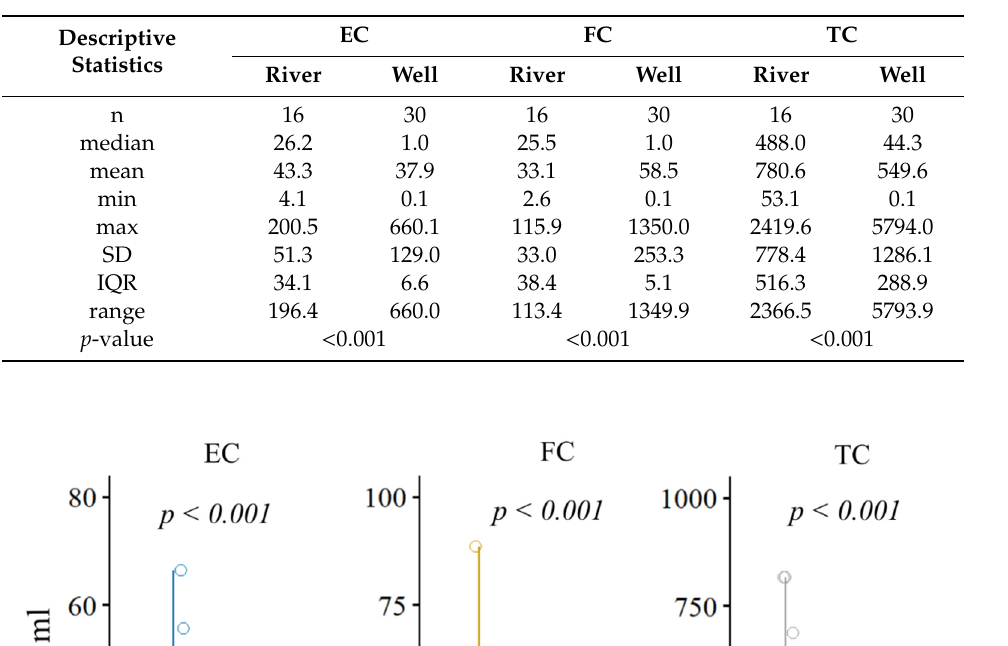
Table 4. Descriptive statistics of coliform concentrations for E. coli (EC), fecal coliforms (FC), and total coliforms (TC), distinguished between river and well samples. The given p-values are the results of the Wilcoxon singed-rank test.